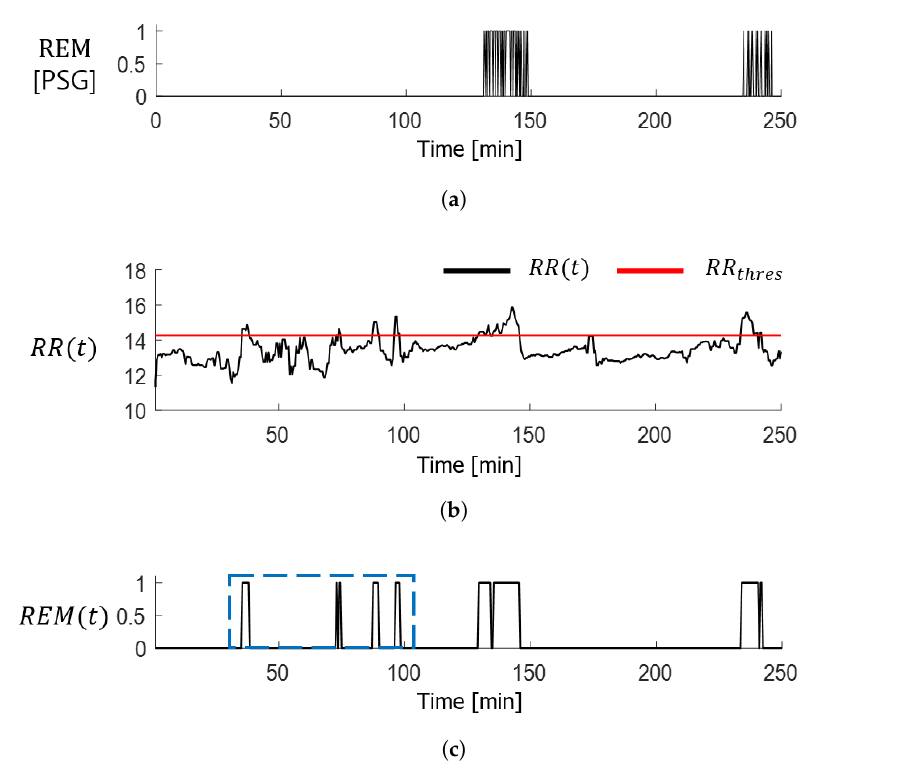
Figure 2. REM sleep stage detected with the FMCW radar. ( a ) PSG results. ( b ) Changes in breathing rate per minute ( c ) Radar-detected REM sleep